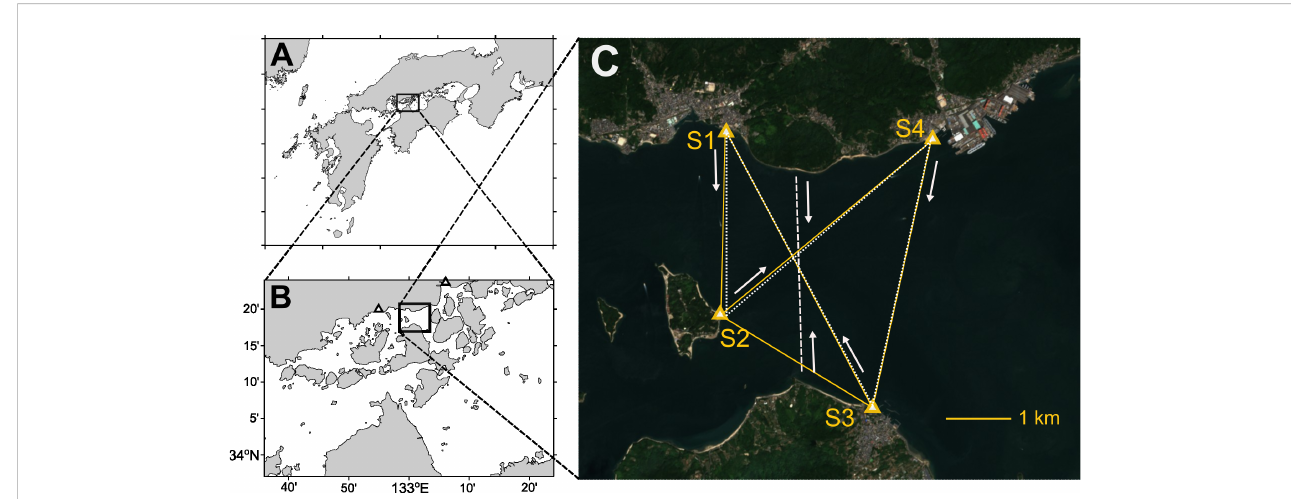
FIGURE 1 (A, B) Geographical location of observation site (Mihara-Seto) in the Seto Inland Sea, Japan; (C) satellite (Sentinel-2) image of observation site and locations of acoustic stations (four triangles with labels S1, S2, S3, and S4). The two black triangles in panel (B) is the location where astronomical tide information is obtained: Takehara for the west and Itozaki for the east. In panel (C) , the fi ve yellow lines are the acoustic transmission paths over each station pair; the white dashed and dotted lines indicate the tracks of shipboard acoustic Doppler current pro fi ling (ADCP) observation performed on Oct. 30 and 31, respectively, with the arrows for the route